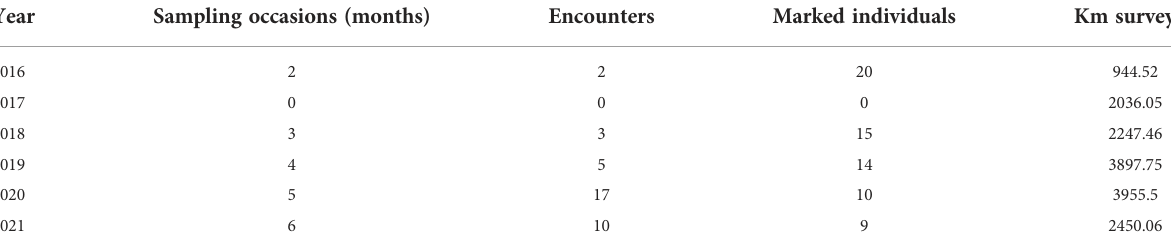
TABLE 2 Sampling effort used in the closed population models for the common